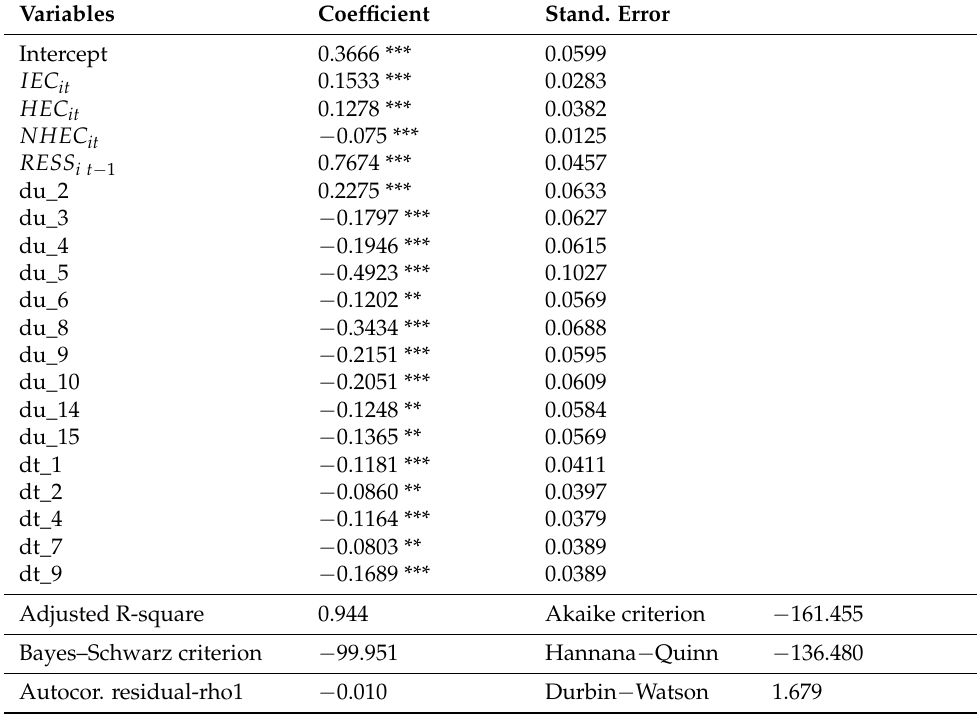
Table 4. Dynamic panel data model, the results from least squares dummy variable estimation using 160 observations, including 16 cross-sectional units, time series length = 9, endogenous variable: RESS it